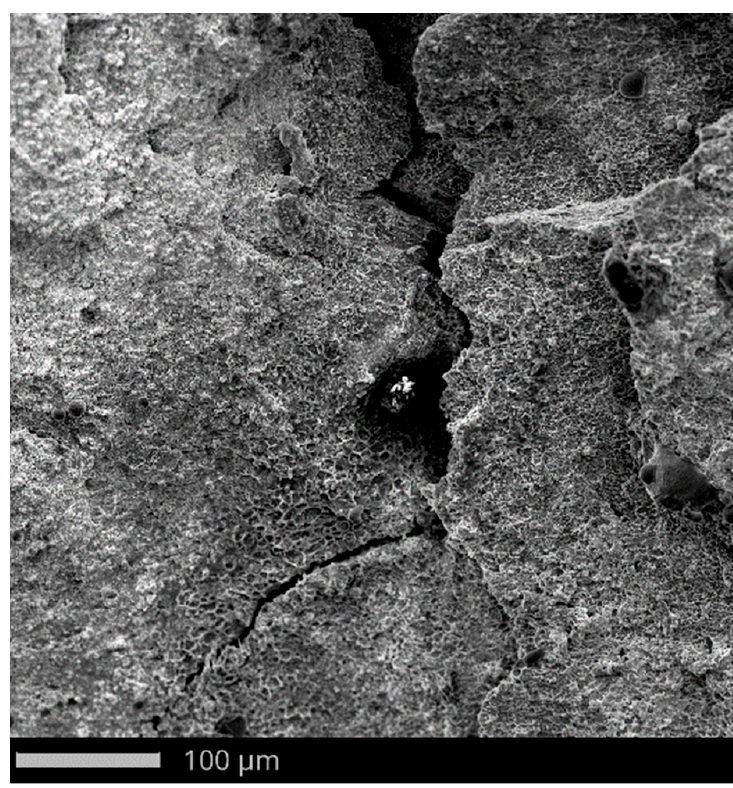
Figure 13. Crack at the edge of the hit.